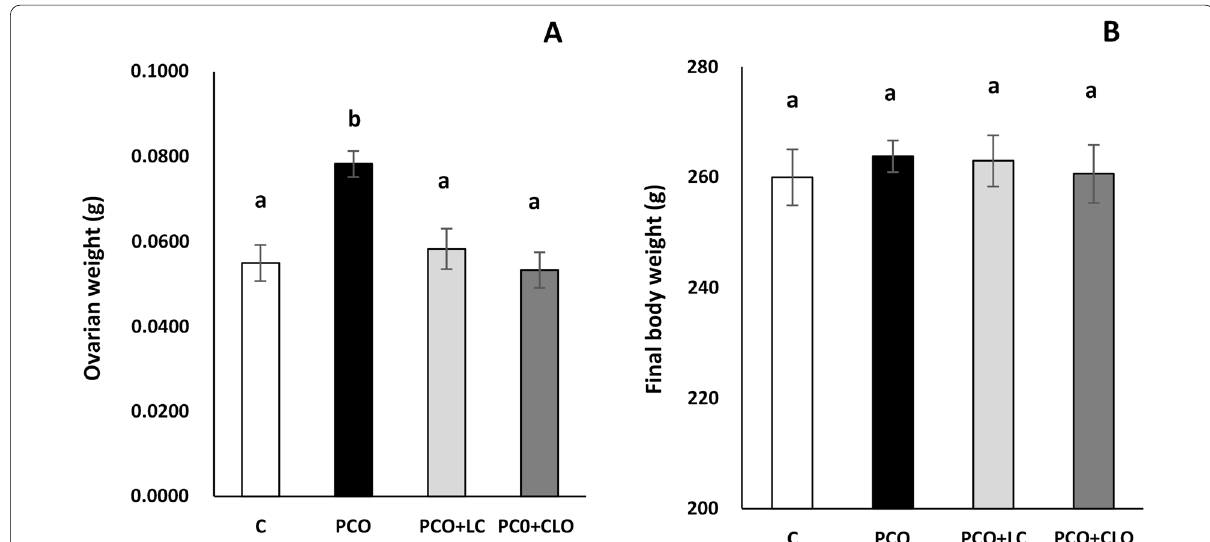
Fig. 1 Effect of l -Carnitine (LC) and Clomiphene citrate (CLO) on Ovarian weight ( A ) and Final body weight ( B ) in different groups. Values presented as mean SE ( n 6). Means denoted with different superscript letters are statistically significant at P < 0.05. C Control group, PCOS letrozole-induced ± = polycystic ovarian syndrome, PCOS